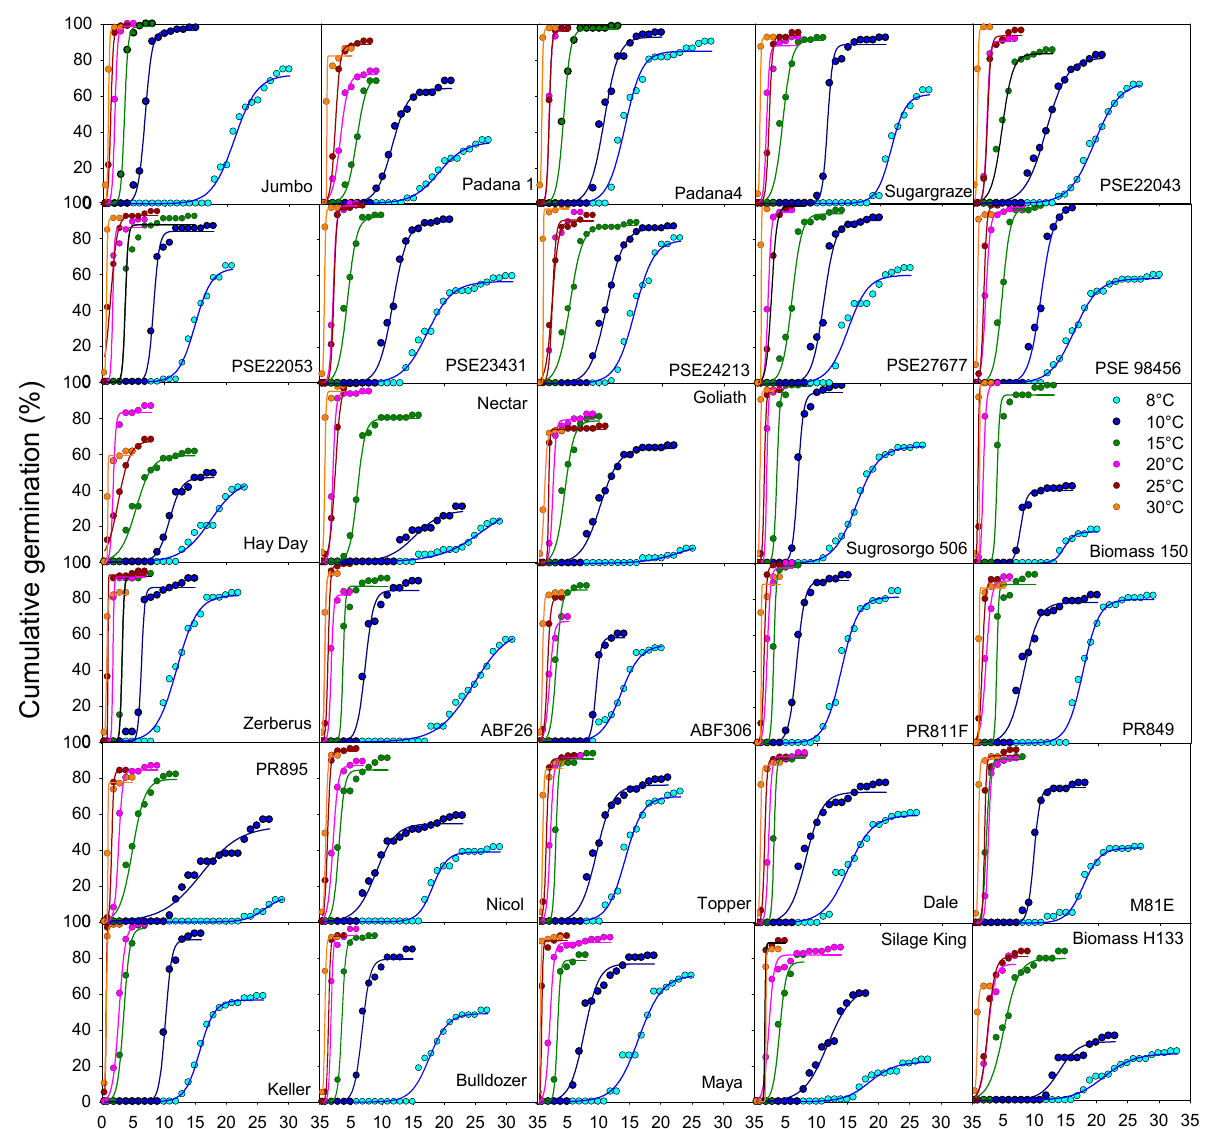
Figure 1. Cumulative germination time courses (solid curves) at different temperatures in 30 cultivars of biomass sorghum. Seeds were germinated at 8, 10, 15, 25, and 30 °C. Symbols represent the observed percentages with time.